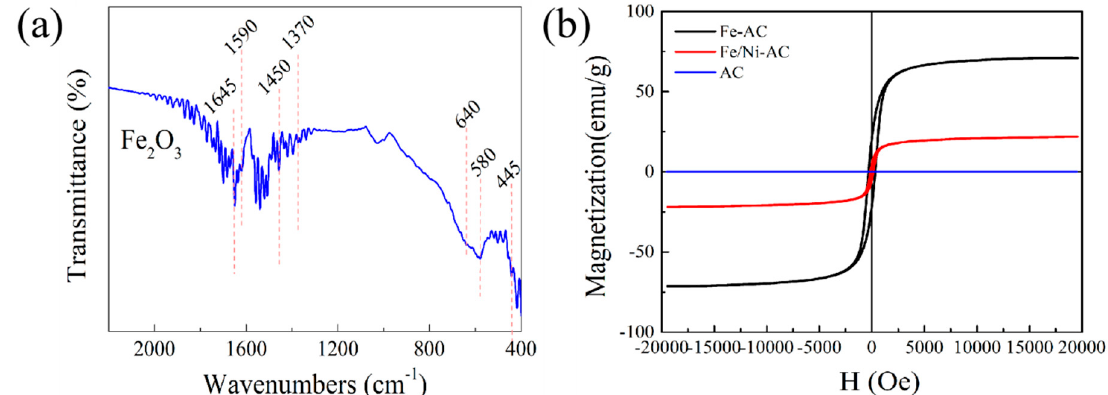
Figure 5. ( a ) FT-IR spectra of the synthesized Fe-AC; ( b ) magnetic hysteresis loops of the Fe-AC, Fe/Ni-AC, and AC. Fe/Ni-AC, and